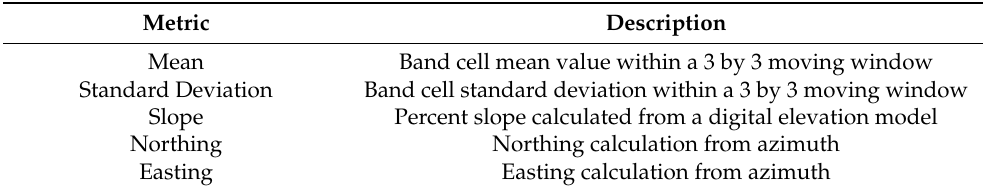
Table 3. List of raster metrics and calculation used to create predictor variable values collected at the location of each plot